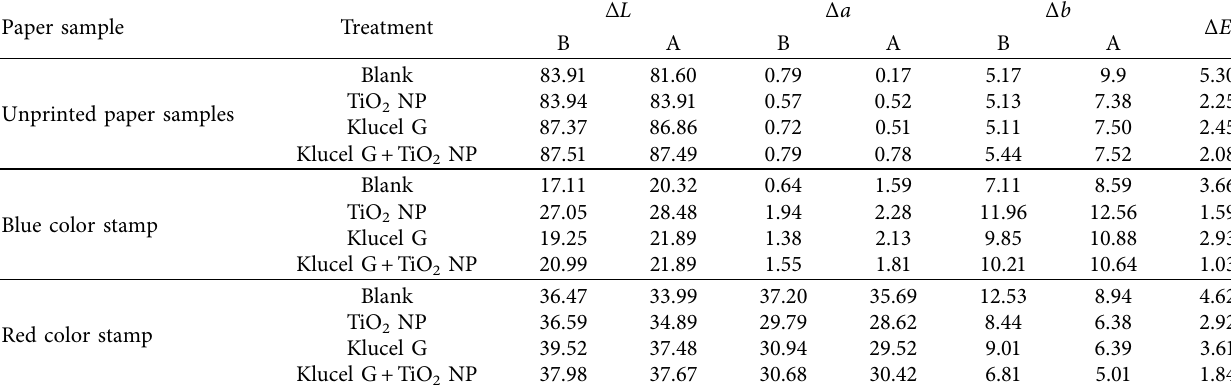
Table 6: Color change measurements of blue and red stamps compared with unprinted papers before and after photoaging. Paper sample Unprinted paper